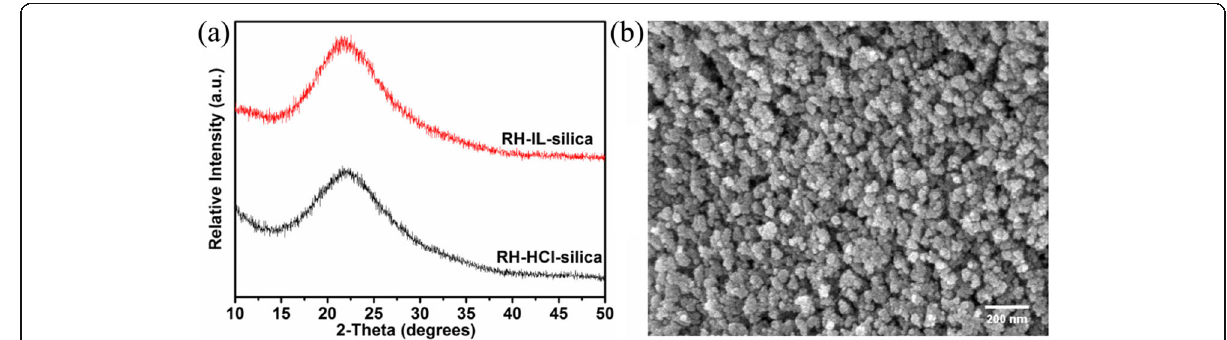
Fig. 5 a XRD patterns of the silica samples synthesized from IL treated RH residue and HCl treated raw RHs; b SEM image of the silica synthesized from IL treated RH